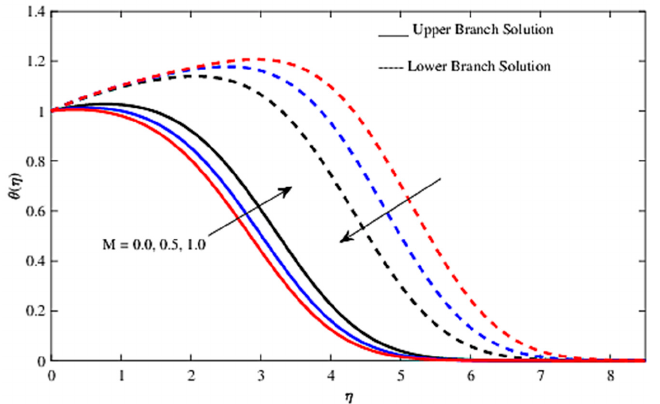
θ ( η ) for several values of M when λ = − 1.2, ε = 1000, Q = 0.1 and Figure 6. Temperature profiles ( )  for several values of M when λ = − 1.2, ε = 1000, Q = 0.1 and Pr = 1.0. Figure 6. Temperature profiles Pr = 1.0.